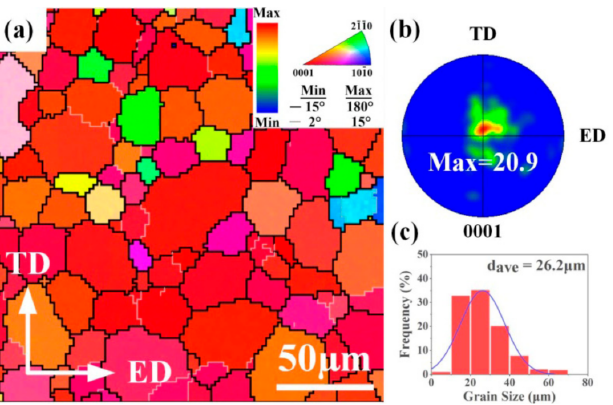
Figure 2. ( a ) IPF map, ( b ) {0001} pole figure, and ( c ) grain size distribution of the as-solutionized sample.